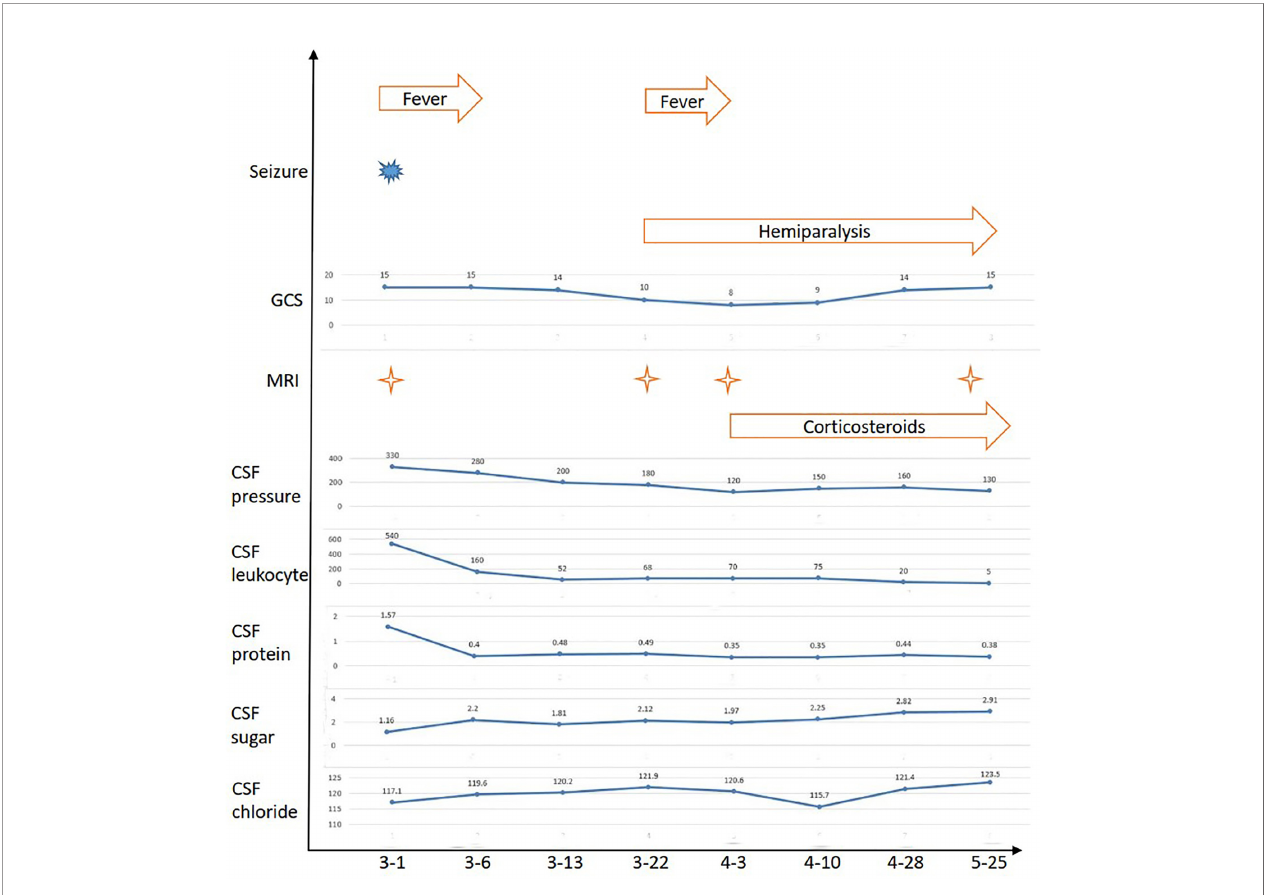
FIGURE 1 | The clinical and CSF evolutions of the